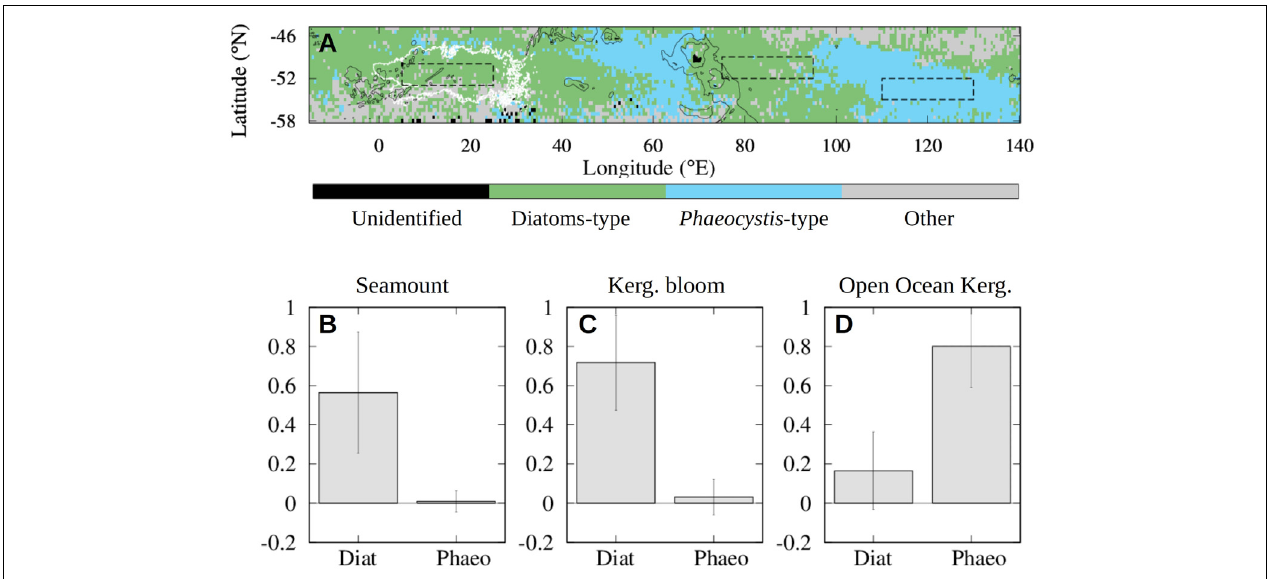
FIGURE 6 | Climatology maps (2000–2011) of dominant phytoplankton groups in December and January estimated using PHYSAT. (A) Most abundant phytoplankton type estimated from PHYSAT over the 2000–2011 time period. The distribution of the Lagrangian plumes from the seamounts (white solid line) is shown as in Figure 5 . (B–D) Mean percentage of time that the seamount region (B) , Kerguelen (abbreviated Kerg. in the image) bloom region bloom region (C) and open ocean region downstream of it (D) are dominated by diatoms or phaeocystis types (respectively abbreviated Diat and Phaeo in the image) during December and January between 2000 and 2011. The three regions are located in the dashed black contours in the top panel. From left to the right these are: seamount region (B) , Kerguelen bloom region (C) and open ocean region downstream of it (D) . Error bars indicate the standard deviation over each